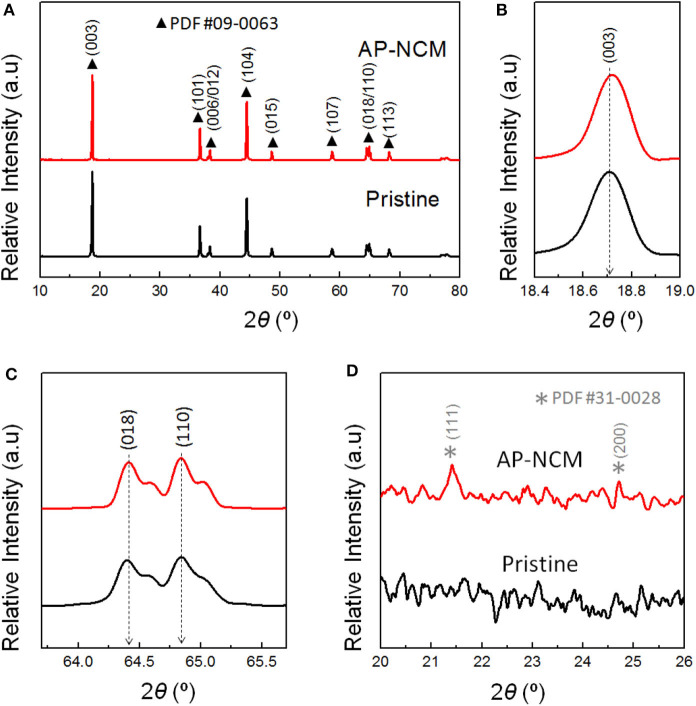
(A) XRD patterns of the Pristine cathode and AlPO4-coated AP-NCM, and (B) the expanded view of the NCM (003), (C) NCM (018/110) and (D) AlPO4 reflections.